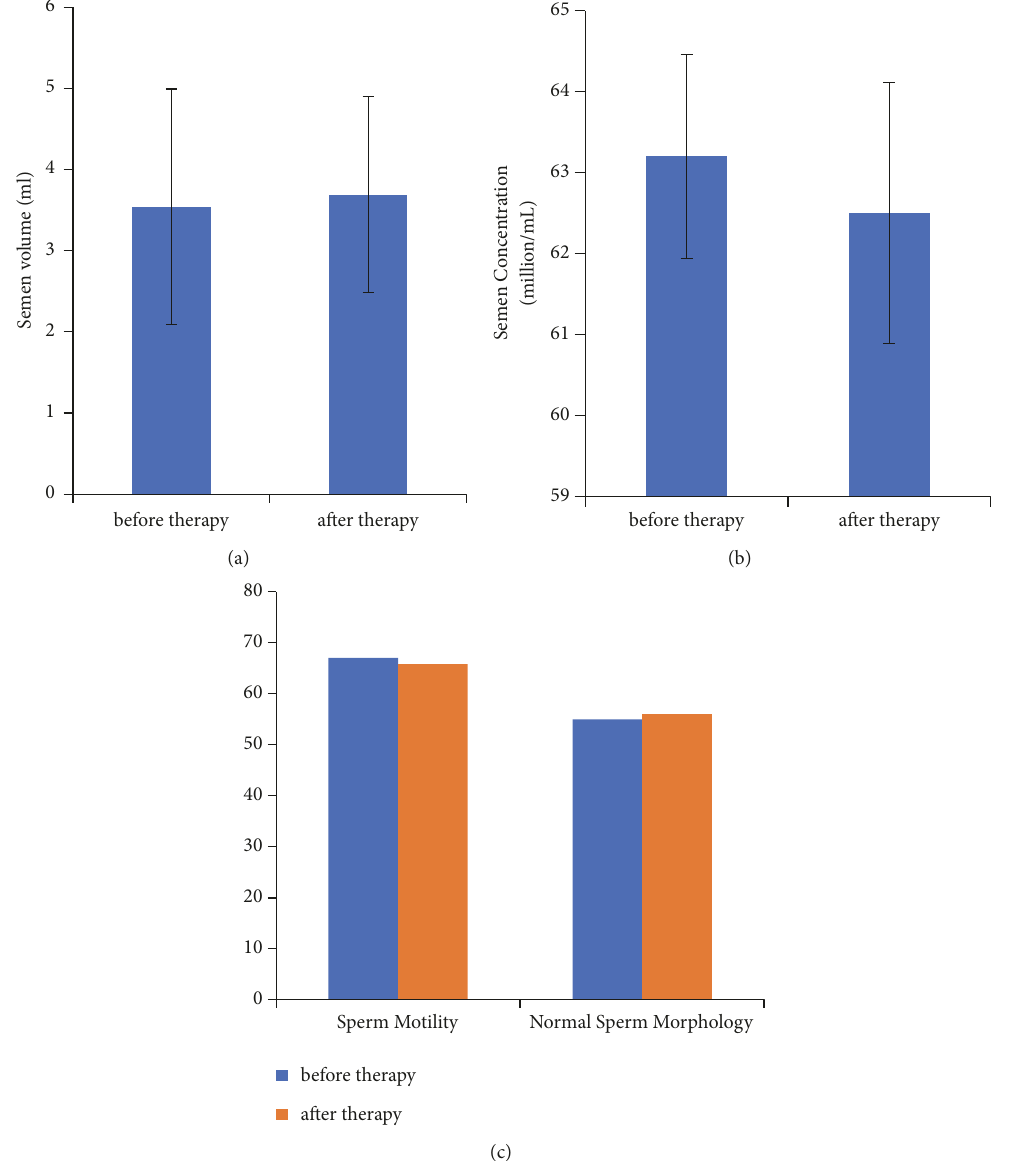
Figure 4: Effect of antiviral therapy on semen and sperm. (a) Semen volume changes in CHB patients before and after taking anti-HBV therapy. (b) Semen concentration and sperm changes in CHB patients before and after taking anti-HBV therapy. (c) Change in sperm motility and normal sperm morphologies during anti-HBV therapy. HBV: hepatitis B virus; CHB: chronic hepatitis